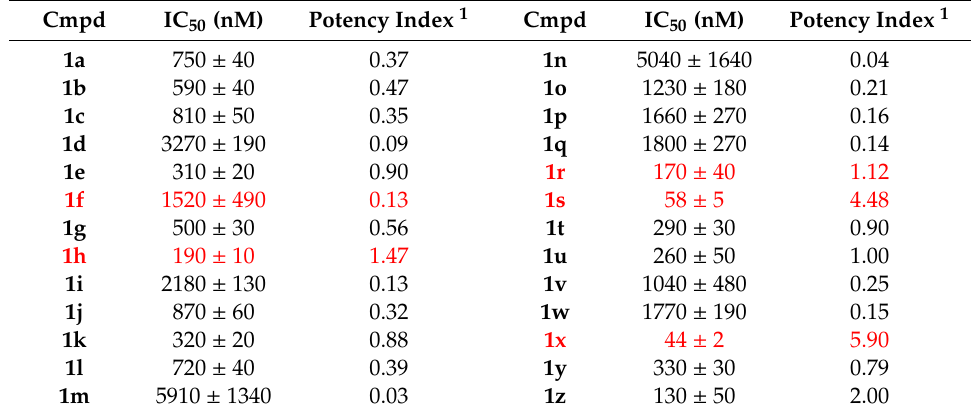
Table 1. Inhibition of Electrophorus electricus ( Ee AChE) by pyranopyrazole tacrines 1a – z (data from [63–65]). Cmpd IC 50